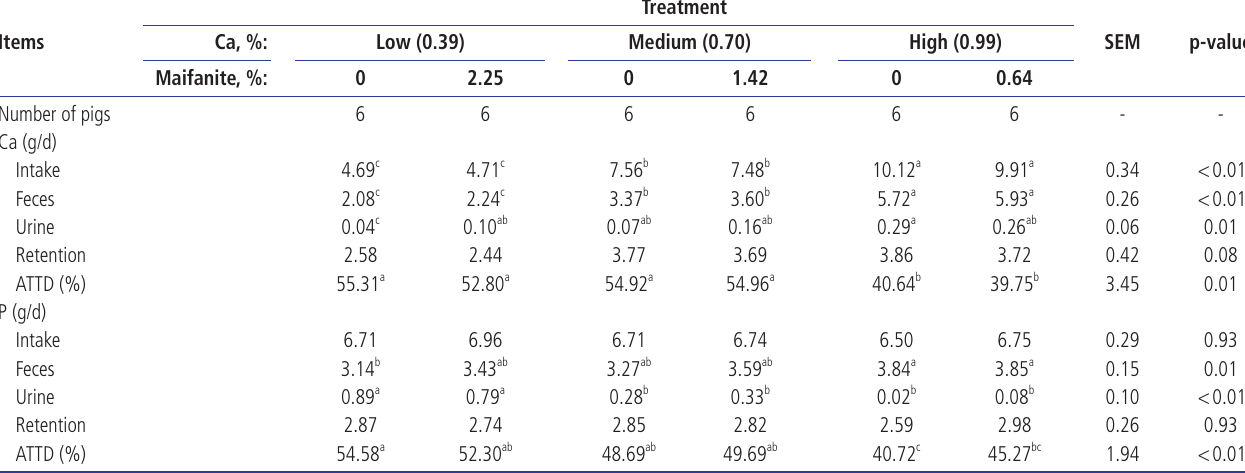
Table 2. Daily balance and apparent total tract digestibility (ATTD) of Ca and P in pigs fed experimental diets with the total collection (TC) method (as-fed basis)